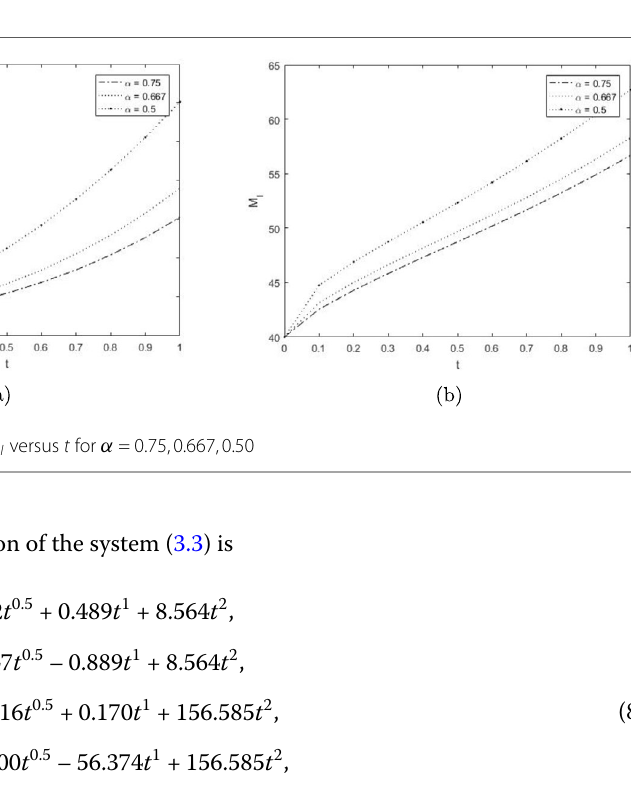
For α = 0.50, the solution of the system (3.3)